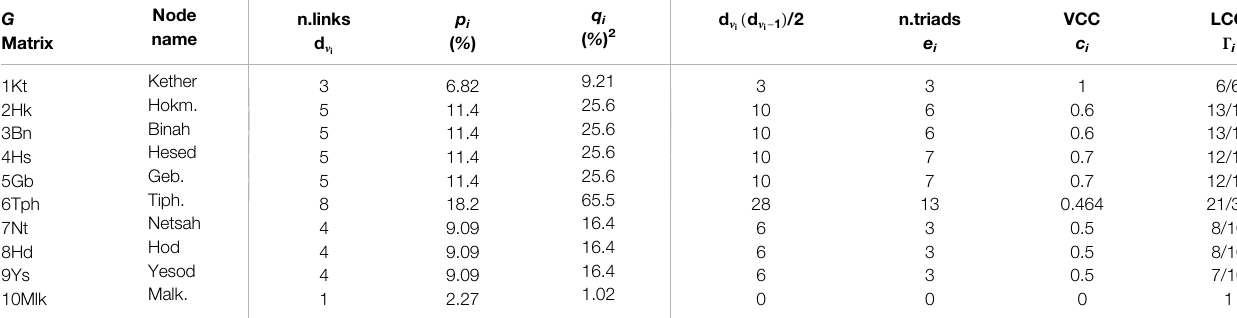
i that a ( d ] − 1 ) /2 ) ;thenumberof i i